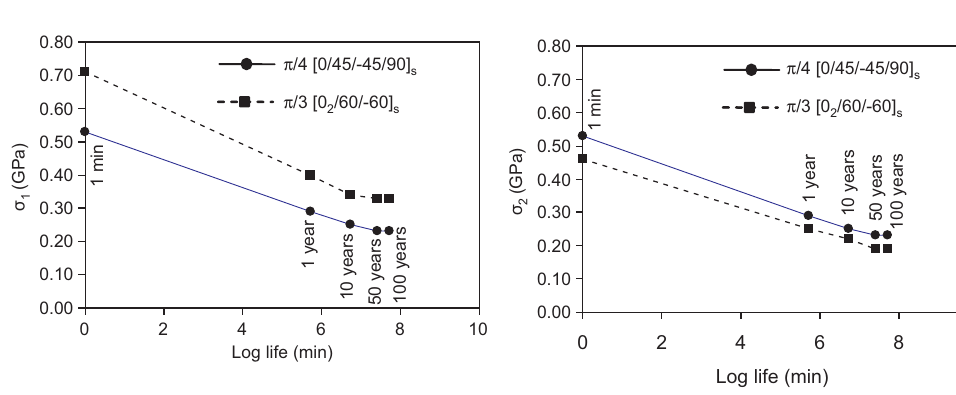
Figure 21 Tensile σ